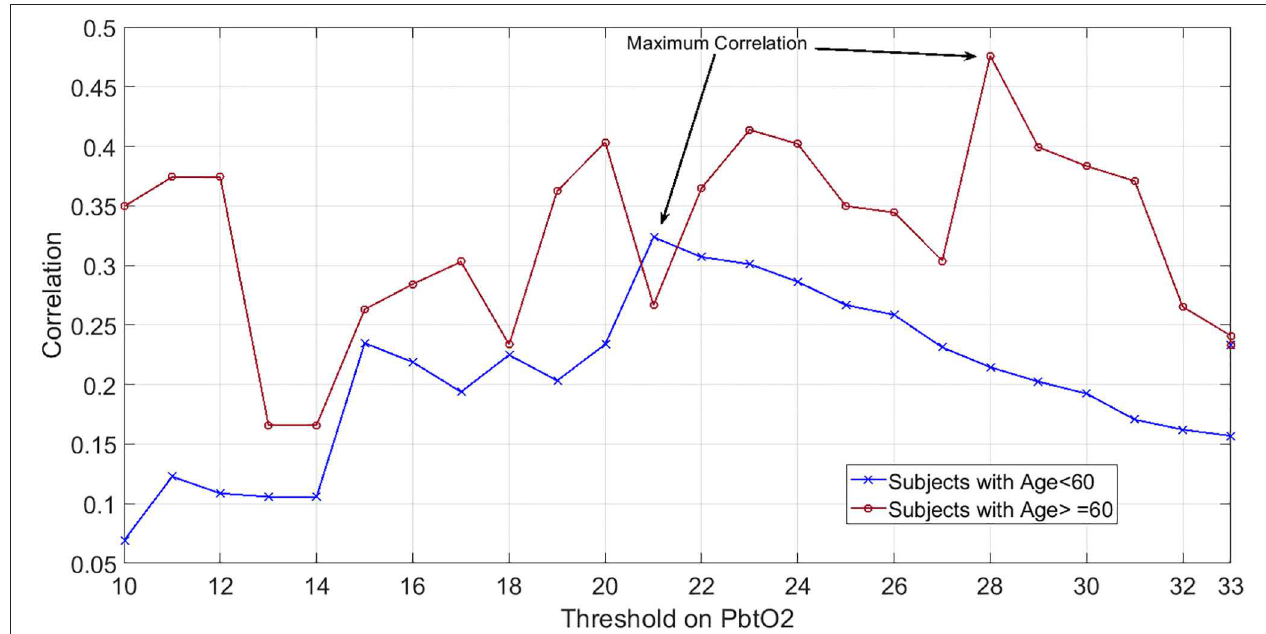
FIGURE 2 | Showcasing dependency of hypoxic PbtO2 threshold to subjects’ age: Correlation values between the percentage of episodes with compromised PbtO2 and the mortality outcome over patients when PbtO2 threshold (shown as horizontal axis) changed from 7 to 40 mmHg. Blue plot indicates the patients younger than 60 years old while red plot shows the correlation results for those who are 60 years old or